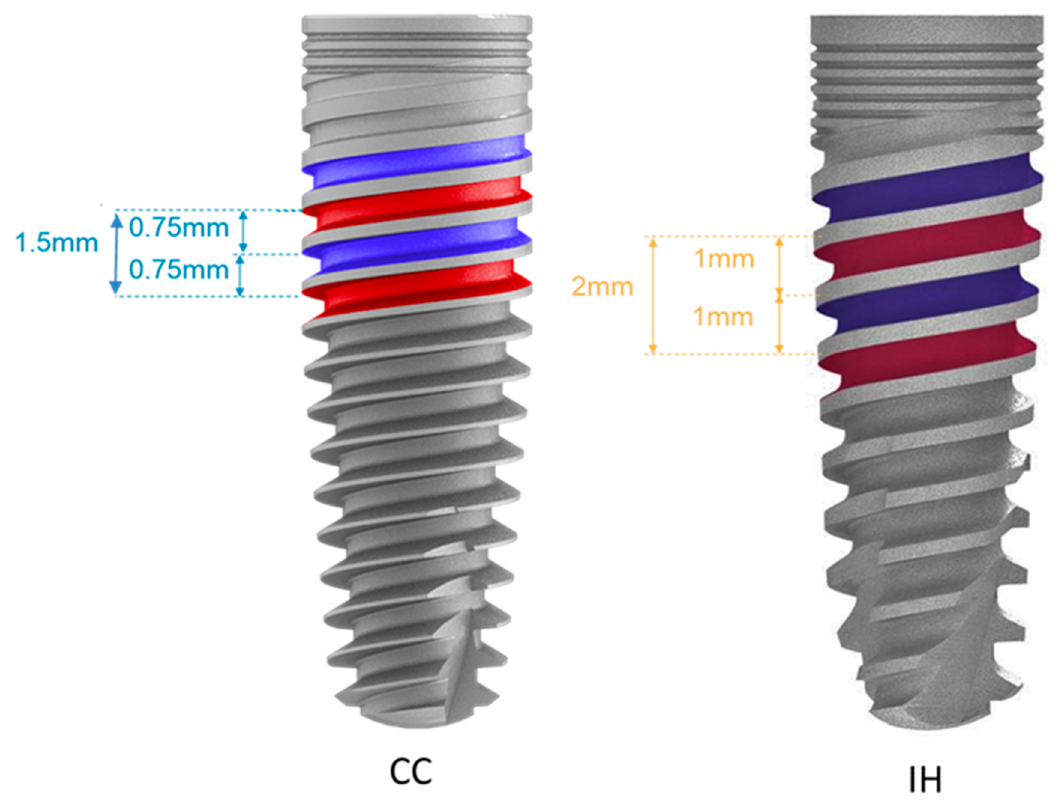
Figure 1. Implant design MIS. CC = Conical connection, IH = internal hexagon .